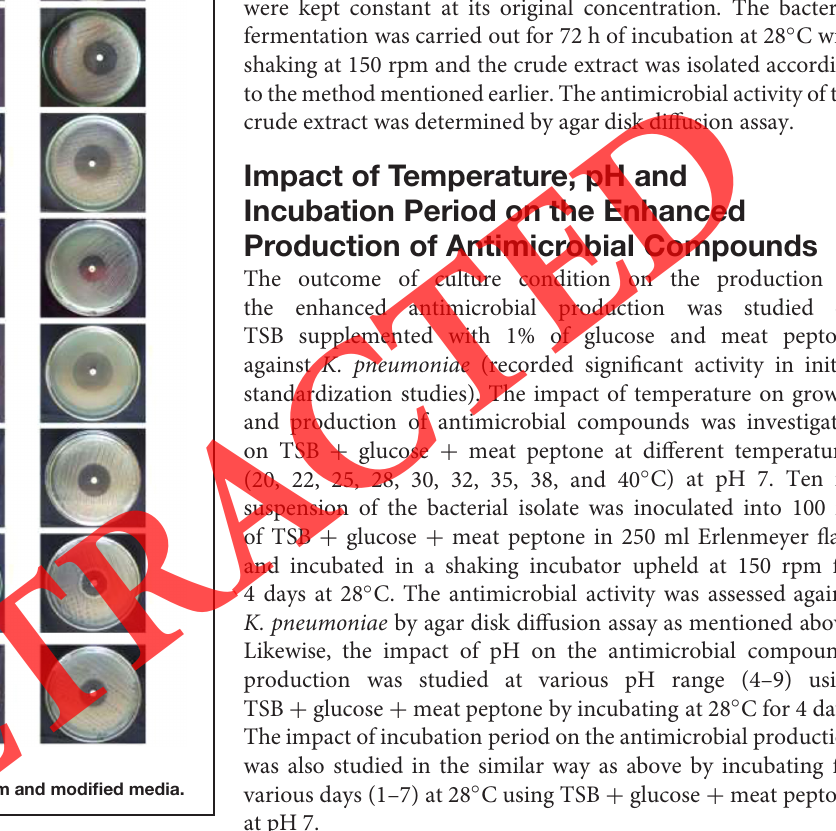
FIGURE 5 | Antibacterial activity of TSB medium and modified media.